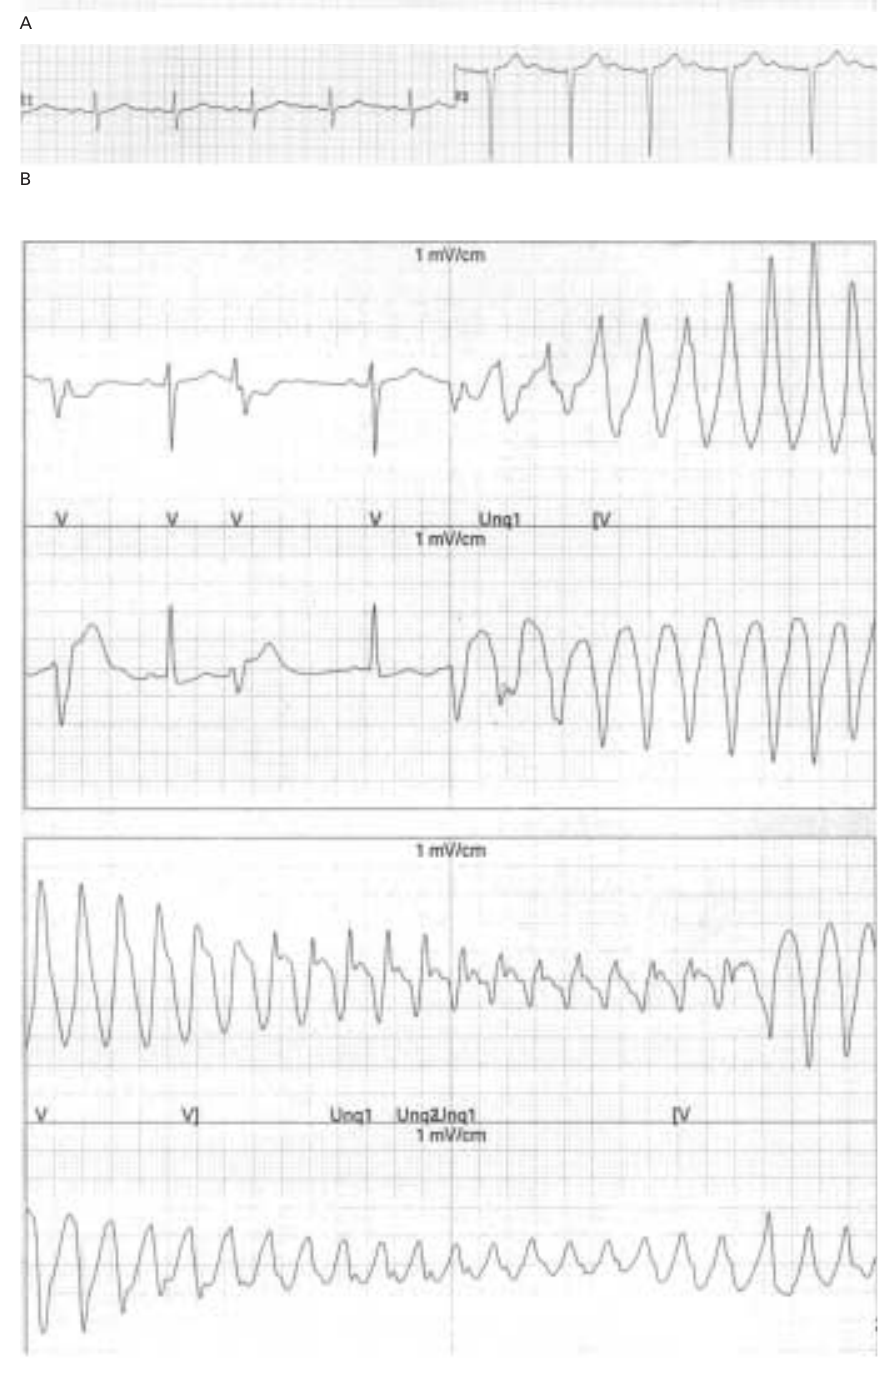
Dose-dependent QT-prolongation by methadone (leads II and V2) A ECG on 120 mg of methadone (QTc